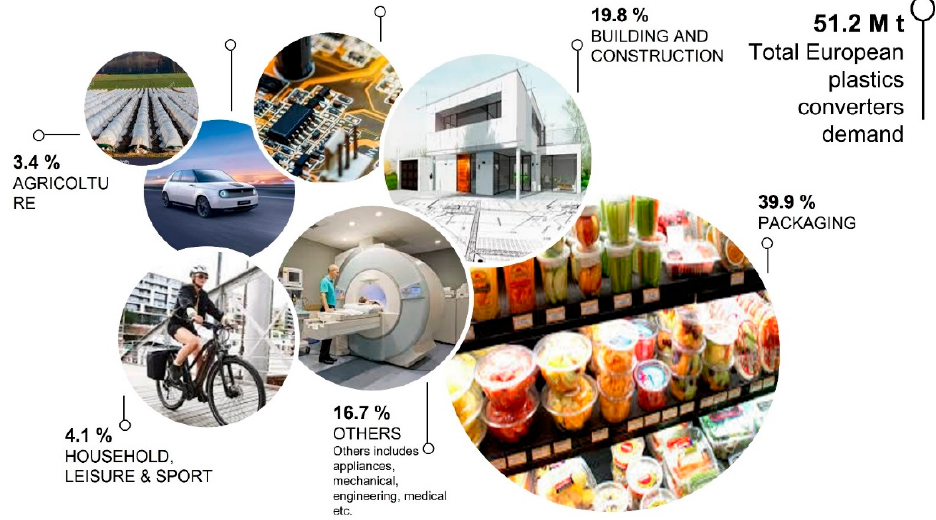
Figure 2. European fossil ‐ based plastic market.